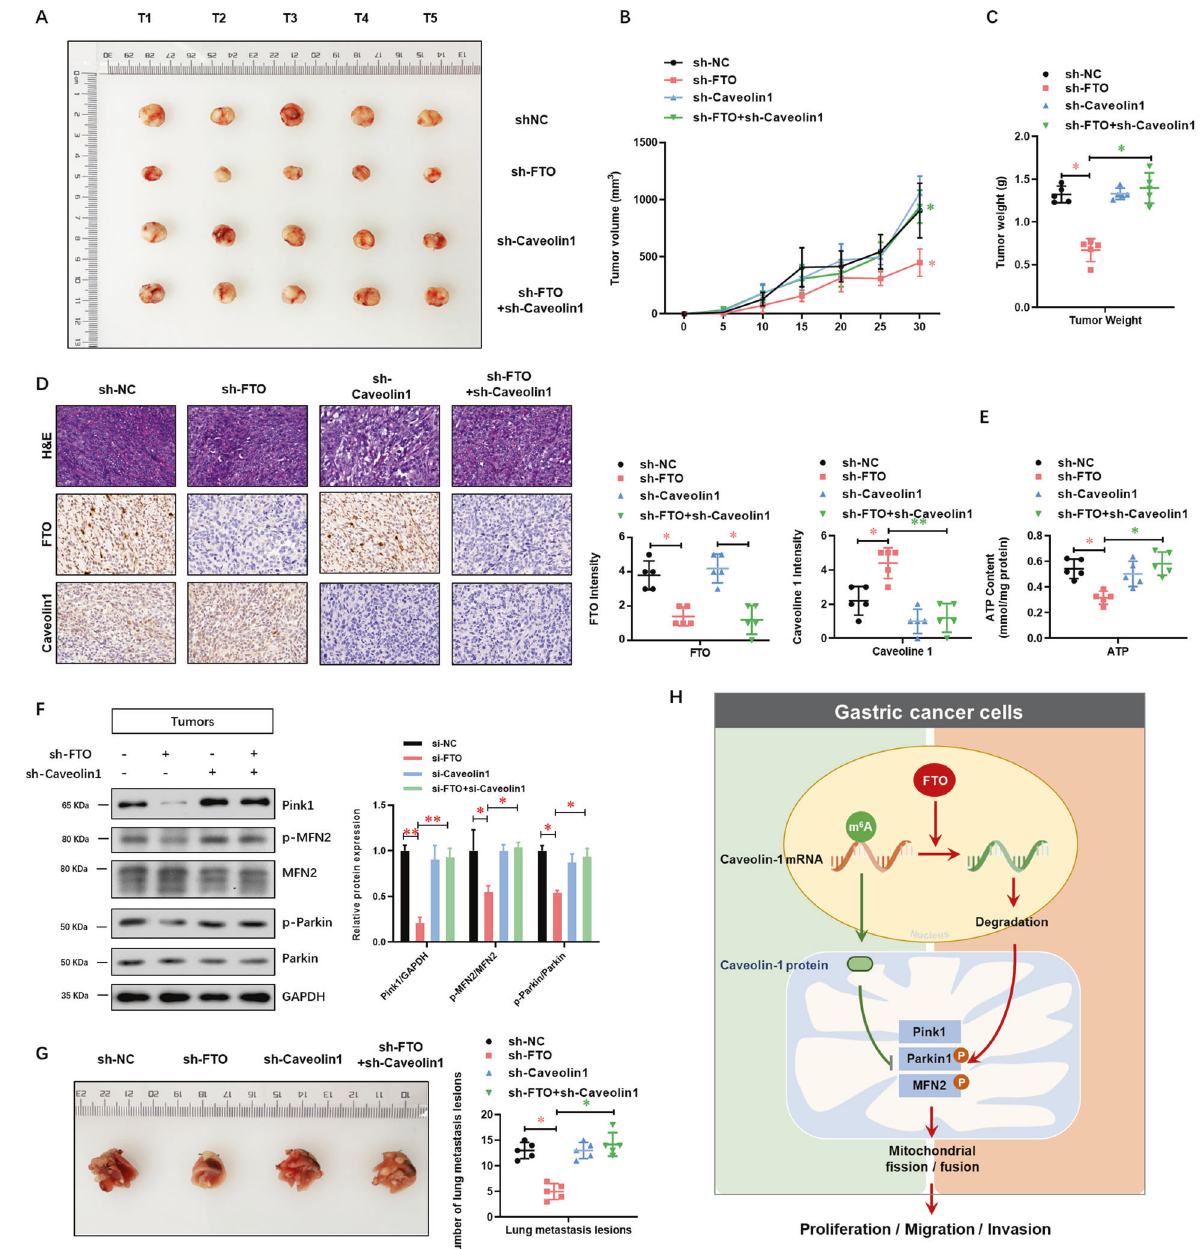
Fig. 8 FTO depletion impairs the tumor growth via caveolin-1 in a xenograft model. A To further con fi rm the effect of FTO/caveolin- 1 signaling on tumor growth in vivo, a subcutaneous tumor xenograft in Balb/c nude mice was established. B The curve of tumor growth and C tumor weight was analyzed. D The expressions of FTO and caveolin-1 at the protein level in these generated tumors were con fi rmed by IHC. E The ATP content in these generated tumors was analyzed. F The regulatory molecules of mitochondrial fi ssion and fusion, including Pink1, Parkin1, and MFN2 in these generated tumors, were analyzed. G To further con fi rm the effect of FTO/caveolin-1 signaling on tumor metastasis in vivo, a Tail Vein injection tumor xenograft in Balb/c nude mice was established. The lung metastasis lesions from four groups of AGS cells were analyzed. H A working model demonstrates that the key demethylase of m 6 A FTO promotes the proliferation and metastasis of gastric cancer via the degradation of caveolin-1 mRNA and regulating the mitochondrial fi ssion/fusion and metabolism. N = 5, * p < 0.05, ** p < 0.01 compared with the indicated